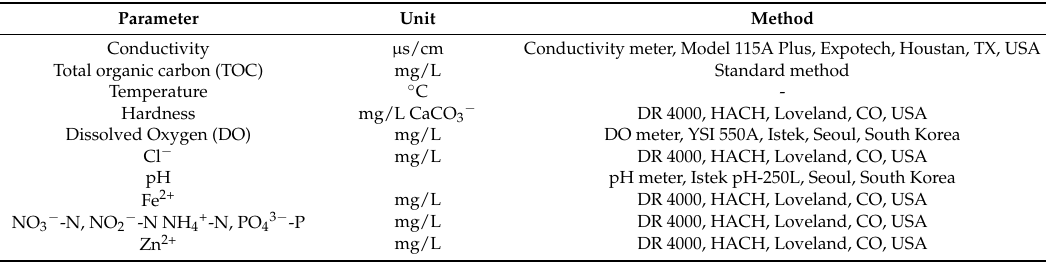
Table 3. Analytical methods for water quality.